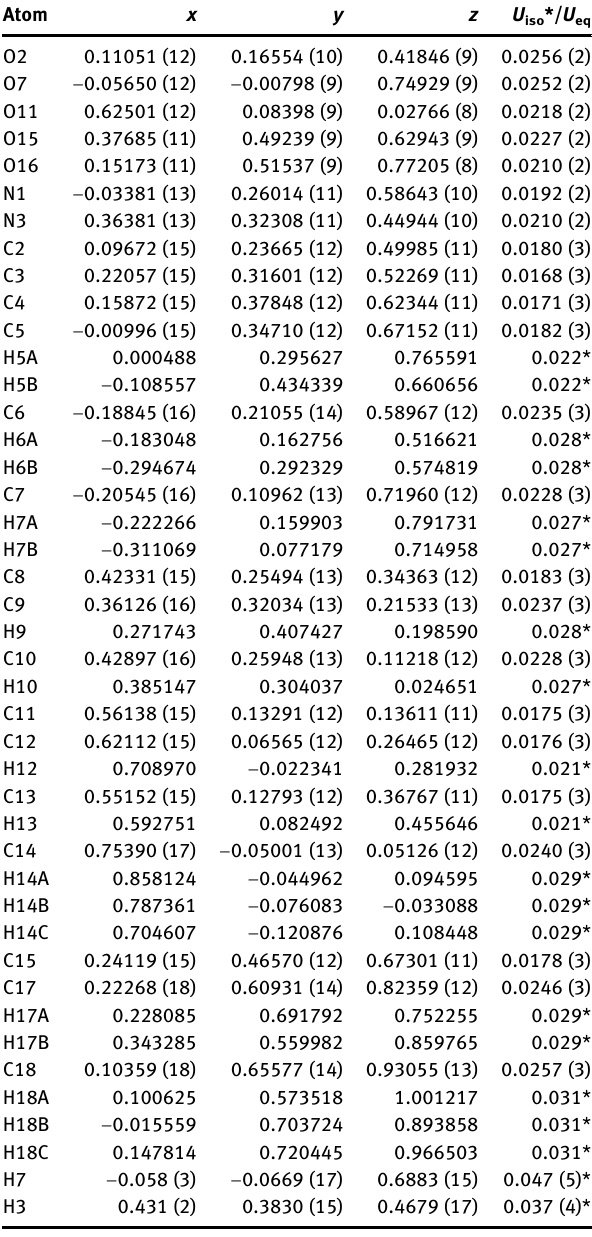
Table  : Fractional atomic coordinates and isotropic or equivalent isotropic displacement parameters (Å 